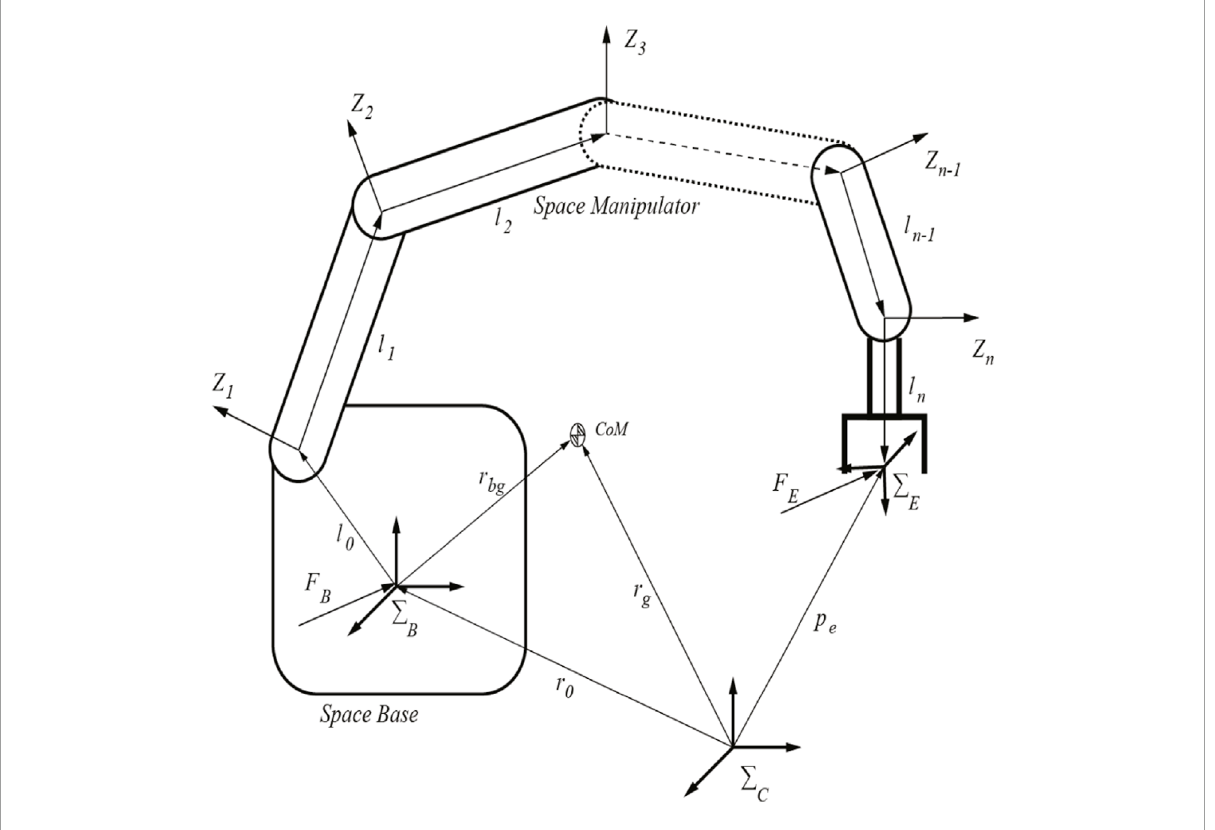
FIGURE 2 The configuration of a space robot and the coordinates of the joints.